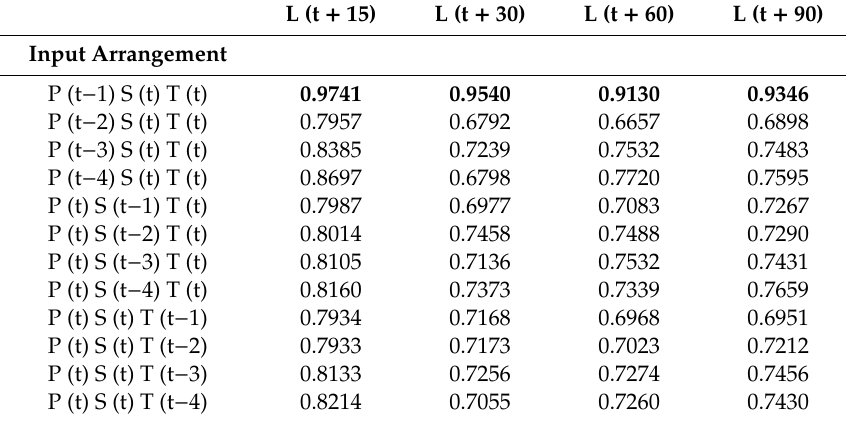
Table 3. NSE performance evaluation criteria for 15, 30 60, and 90 day-ahead groundwater level predictions using the KNN-RF model.